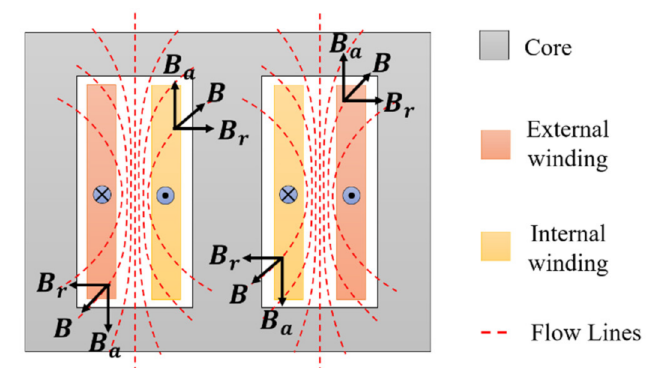
Figure 2. Direction of the magnetic field in the windings by a transformer. Recreated from